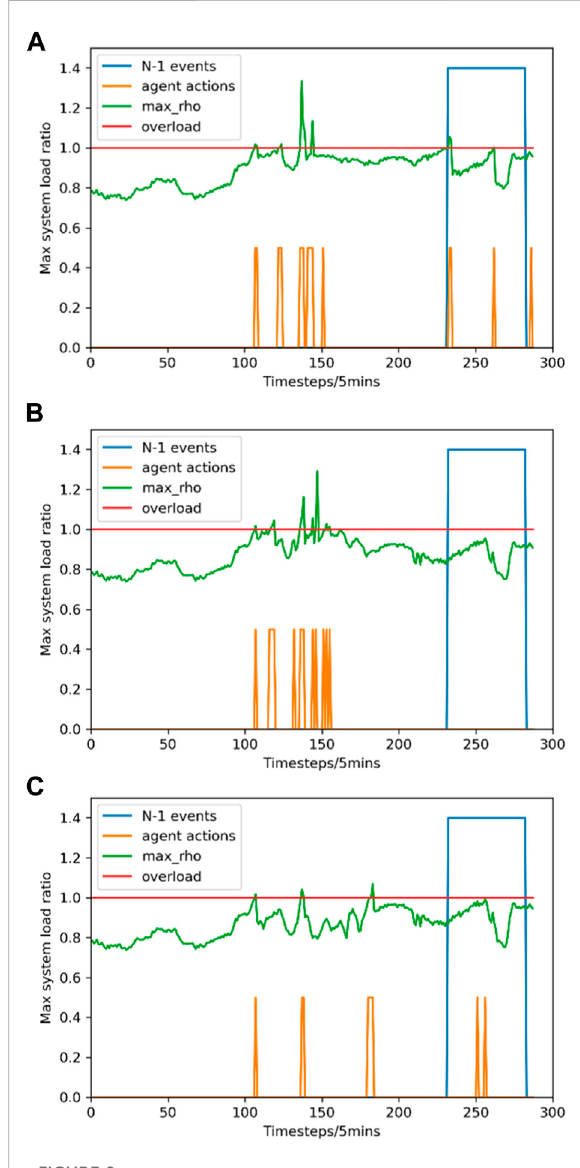
FIGURE 9 System operation status comparison between three